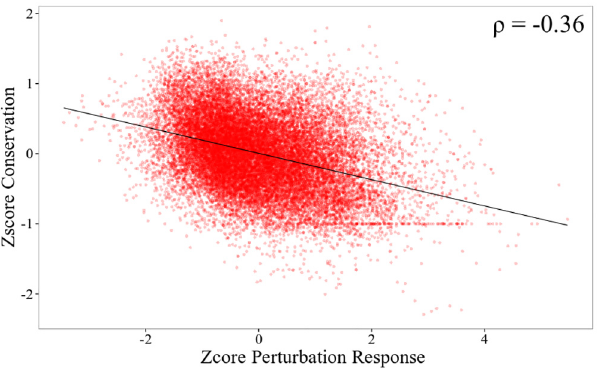
Fig 2. Effect of mutations on vibrations involved in ligand-binding ( Z S i conservation ( Z evol ; i ). Linear regression line is included and linear correlation coef fi cient is shown in the top score right